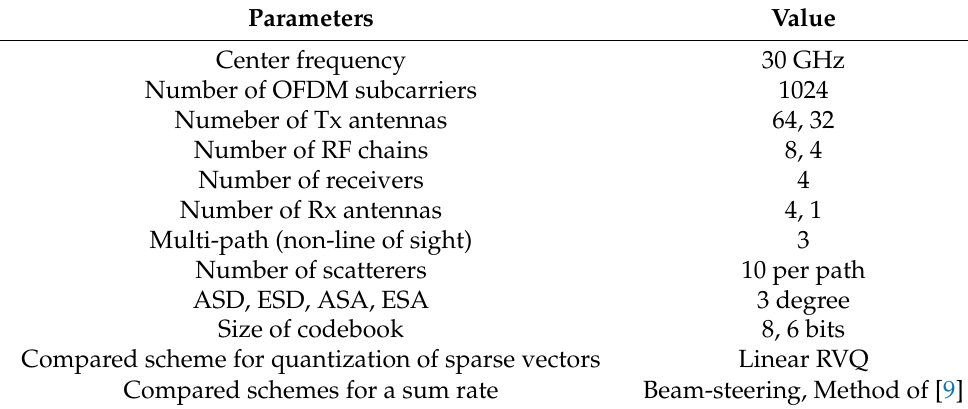
Table 1. Simulation Parameters and Schemes.